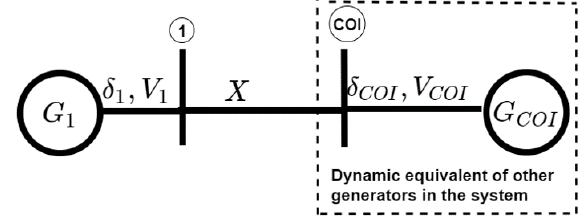
Figure 8. Two-machine equivalent